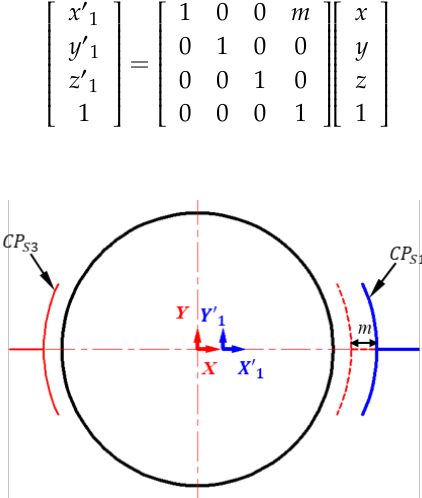
Figure 4. 2D sketch of the spherical capacitance sensor C x when the spherical capacitive plate CP S1 is axial offset from the ideal position.